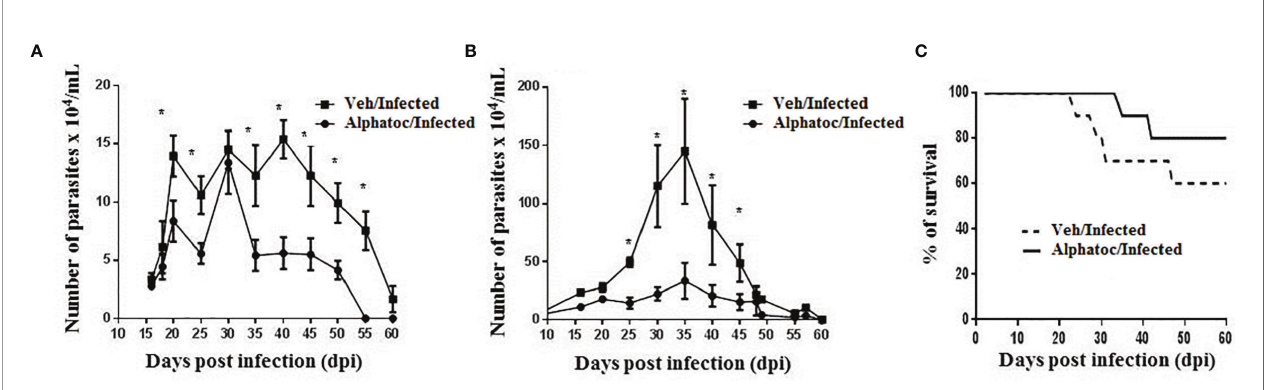
FIGURE 1 | Parasitemia and survival of animals infected with the Tulahuen strain of T. cruzi . In (A) , an inoculum of 50 trypomastigote forms was used. The Alphatoc/Infected group was compared to the Vehicle (Veh)/Infected group (p=0.0238, day 20; p=0.0238, day 25; p=0.0238, day 35; p=0.0159, day 40; p=0.0238, day 45; p=0.0238, day 50; p=0.0079, day 55), Mann Whitney test, n=10. In (B) , mice were infected with 10 3 forms of parasites and the Alphatoc/Infected group was again compared to the Veh/Infected group (p=0,0079, day 25; p=0,0159, day 30; p=0,0397, day 35; p=0,0476, day 40; p=0,0476, day 45), Mann Withney test, n=10 at the beginning of the experiments). In (C) , Results represent the survival curves for infection with 10 3 trypomastigote forms. Differences between the two experimental groups are indicated (Log-rank (Mantel-Cox) test, P=0.0182, n=10 at the beginning of the experiment). The asterisk (*) shows statistically signi fi cant differences. Data are for one representative experiment out of two similar